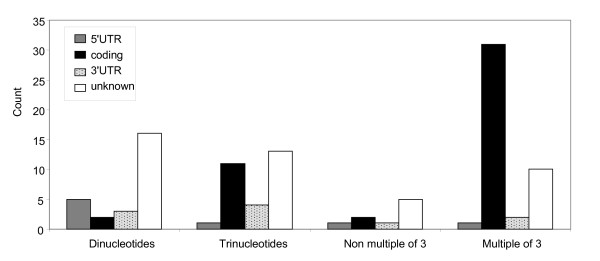
Distribution of repeat structures and localisation in the mRNA. Localisation of repeated motifs predicted with the FGenesh software. "5'UTR": 5' untranslated region; "coding": protein coding region; 3'UTR: 3' untranslated region; "unknown": loci for which the location of the repeated motif could not be ascertained. Total number of loci = 106.